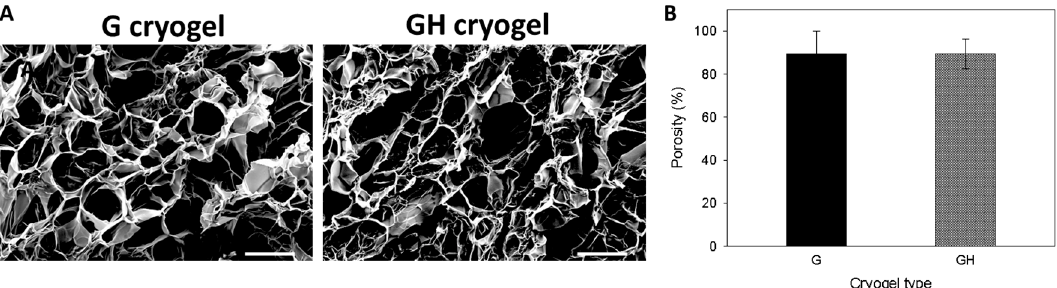
Figure 1. The SEM micrographs ( A ) and porosity ( B ) of gelatin (G) and gelatin/hyaluronic acid (GH) cryogels. Bar = 100 μ m.